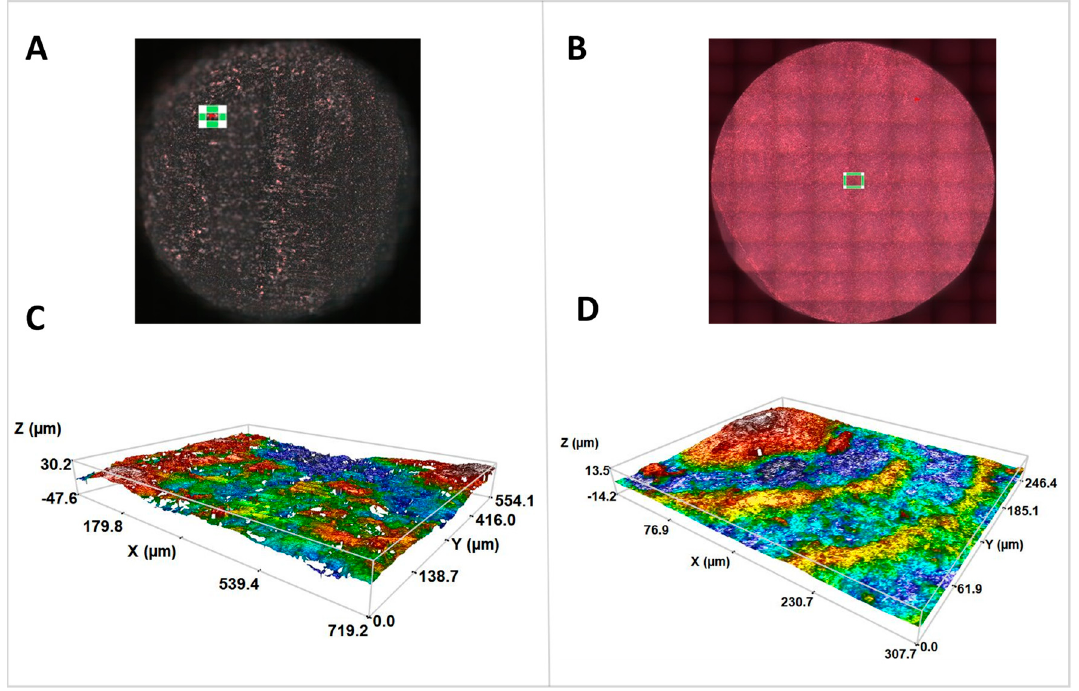
Figure 3. Measurement areas of ZLS ( A ) and Y-TZP ( B ) and profilometry of the samples, objective 20×. ( C ) ZLS; ( D ) Y-TZP.